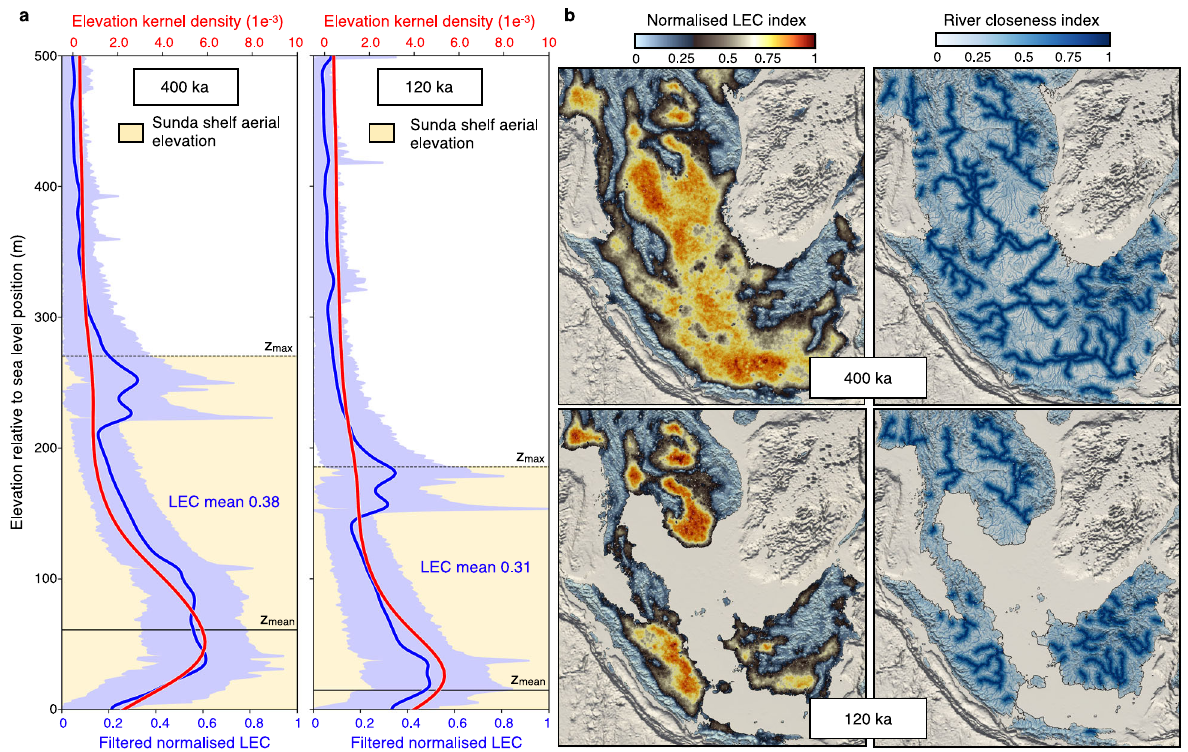
Fig. 4 Geomorphic parameters used for cost surface calculation. a Plots of normalized landscape elevational connectivity (LEC) for the entire aerial domain and within elevational bands (blue lines and standard deviation in light blue), and elevation kernel density (red lines) for the entire exposed domain at chosen time intervals for the simulation forced with variable tectonic map and the sea level curve from 37 . Yellow areas represent the Sunda Shelf aerial elevation extent, with lines showing the exposed shelf mean and maximum elevations ( z mean and z max ). b Examples of LEC and river closeness indexes maps for fully exposed (400 ka) and fl ooded (120 ka) Sunda Shelf conditions. These indexes combined with local slope distribution are then used to produce cost surfaces at speci fi c time intervals over which preferential pathways are